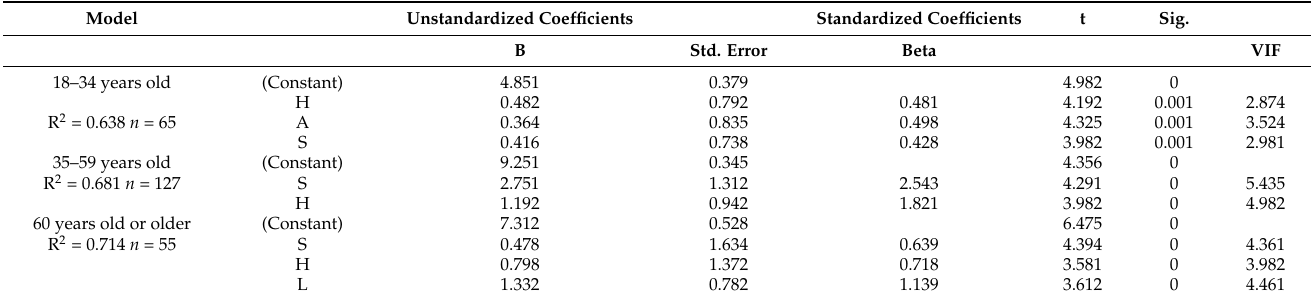
Table 10. The linear regression analysis of the photos’ physical properties for different age groups.